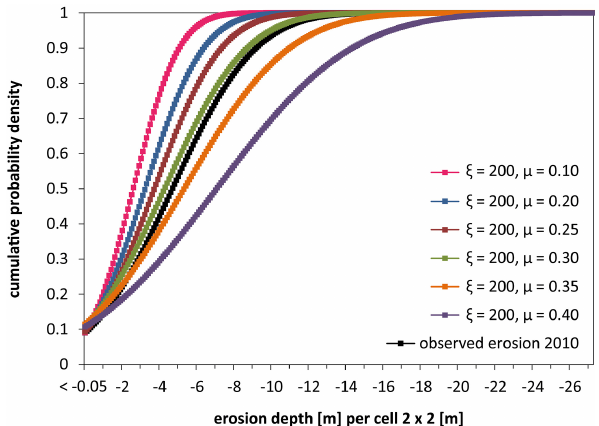
Figure 7. Cumulative probability-density plot of modeled vs. ob- served erosion depths for the two events of 2010 (Table 3) based on a grid resolution of 2m by 2m in bins 1 to 54, for a total of 12621 cells, using the DTMs of April 2010 and August 2010. Erosion is also included and represented on the x axis (< − 0.05m), while no erosion cells and cells with deposition are not